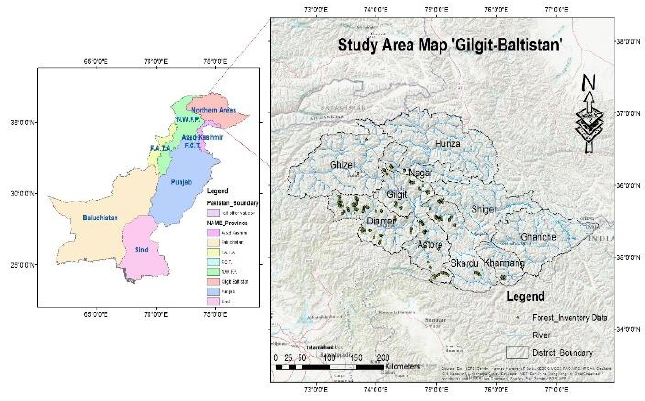
Figure 1. Study Area Map.